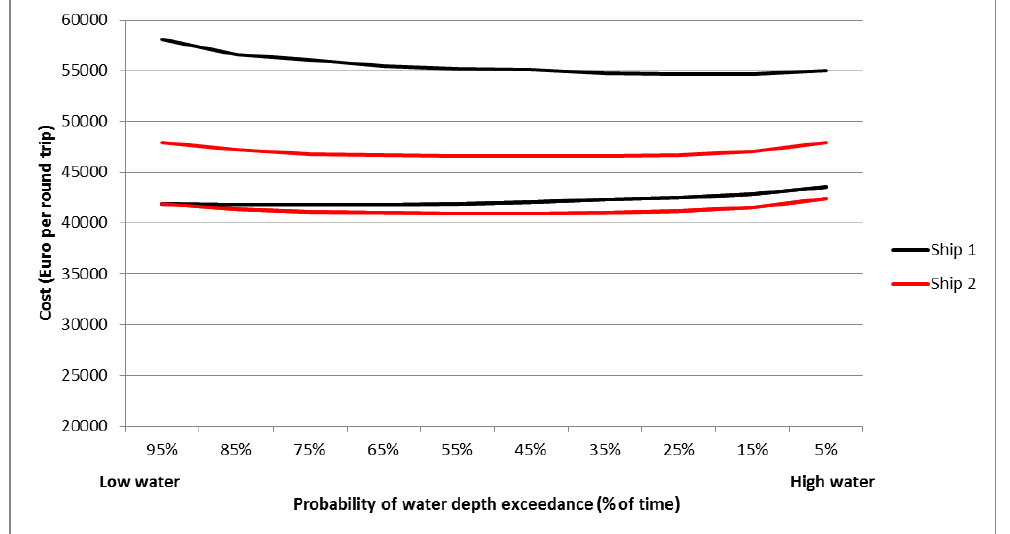
Figure 10. Bandwidth of cost per